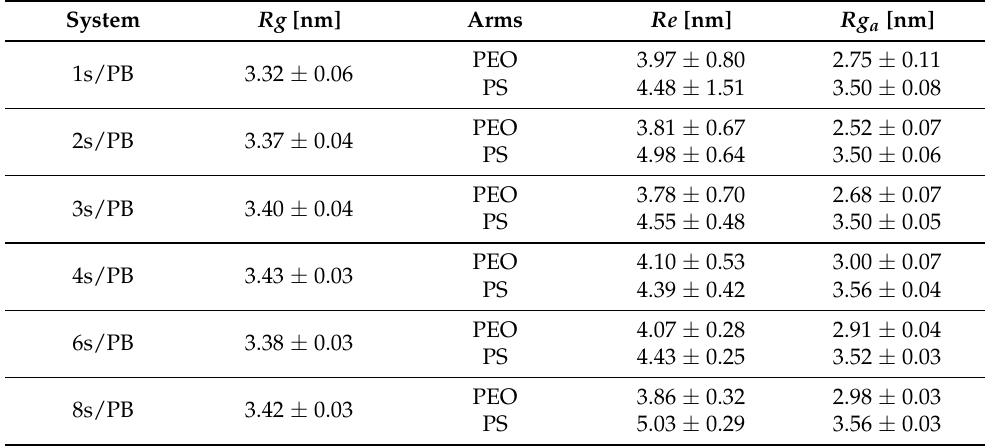
Table 1. Characteristics of the systems. Rg denotes the star radius of gyration, Re the size of the arm center-to-end vector, and Rg a the arm radius of